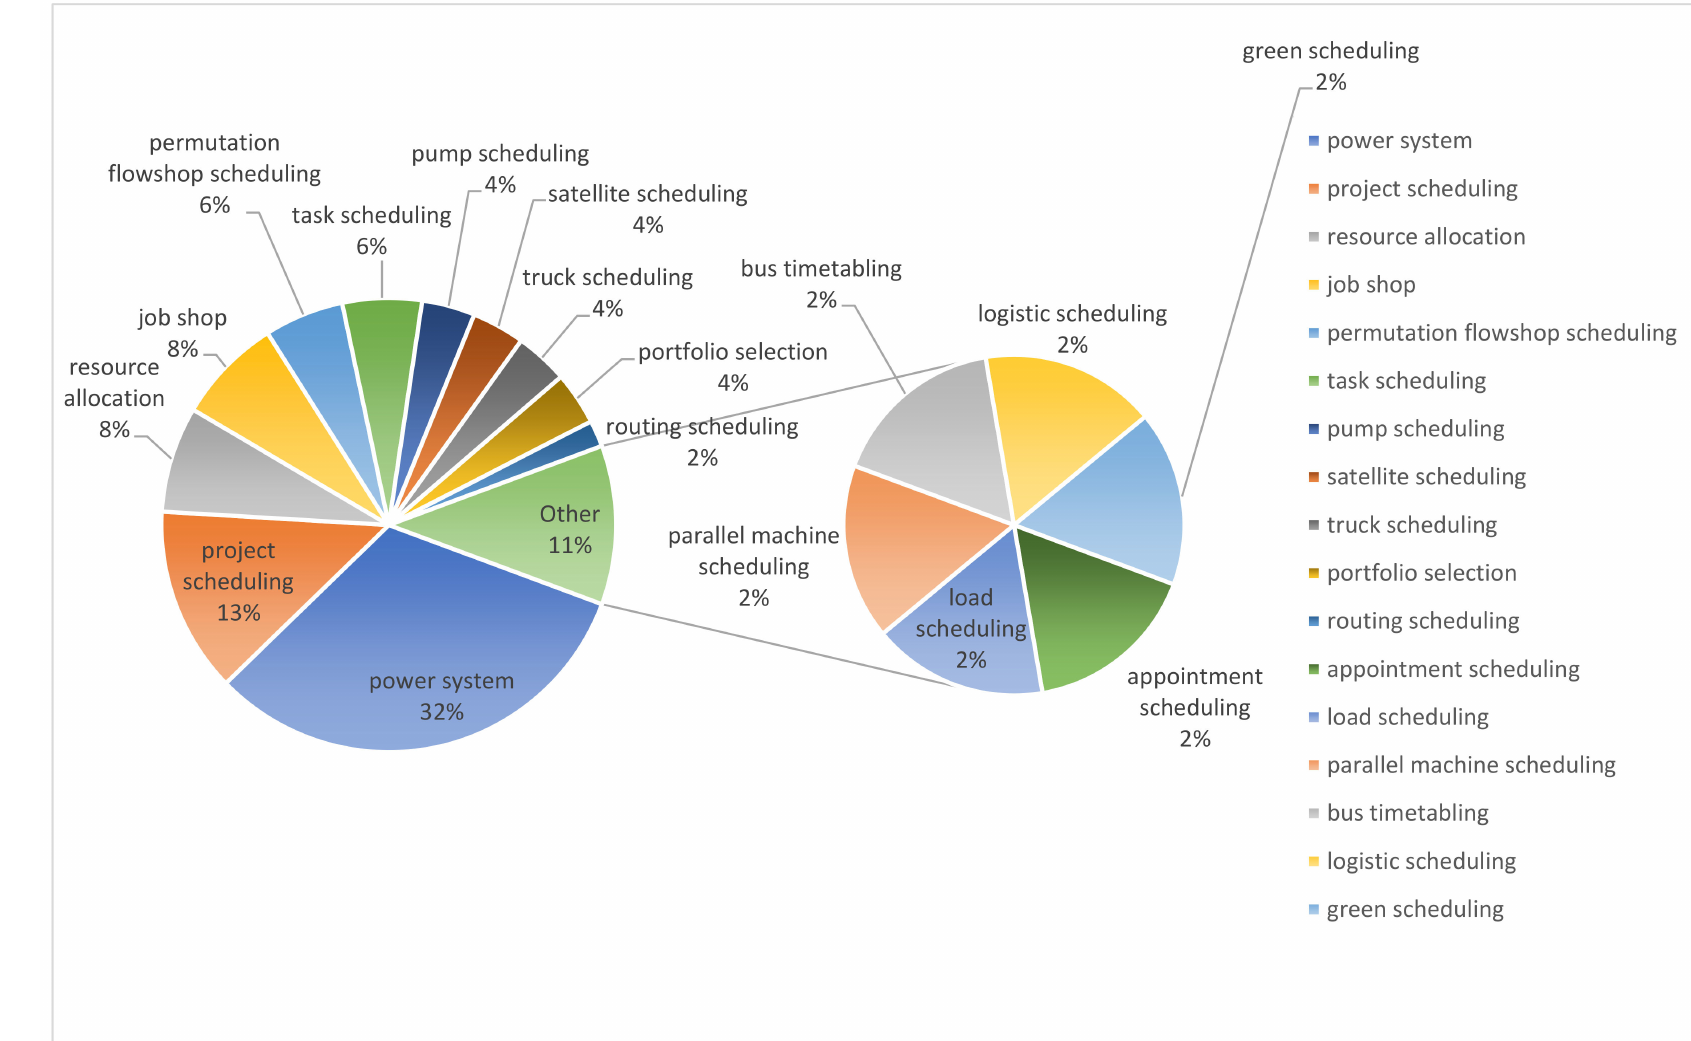
Figure 7. Different uncertainty scheduling problems that have been solved by